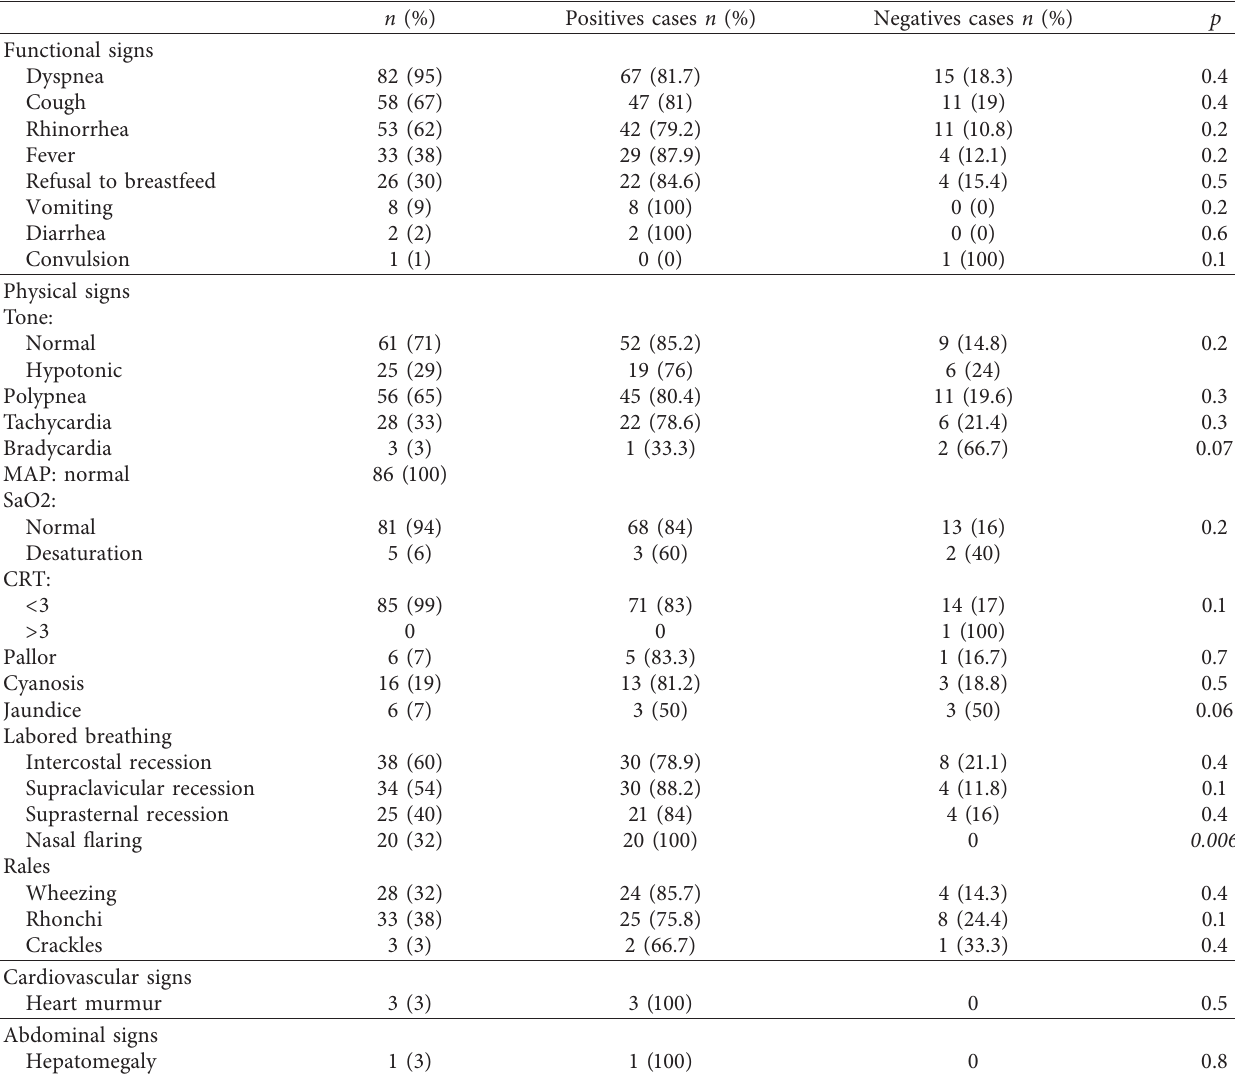
Table 2: Clinical characteristics of hospitalized patients (December 1, 2016, to May 31, 2018; N � 86).